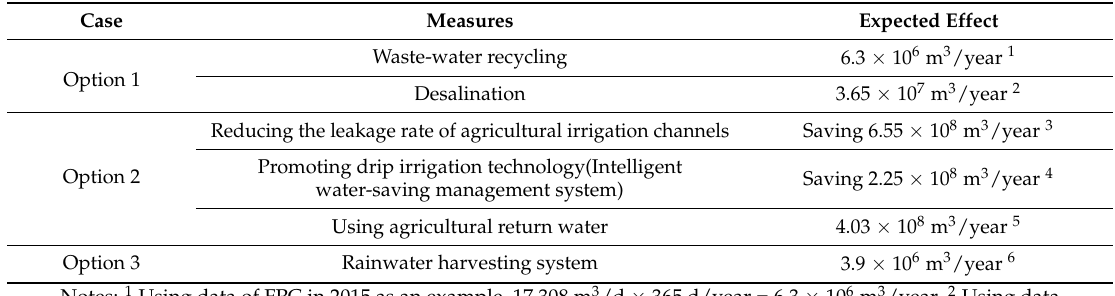
Table 7. Adaptation options and the expected